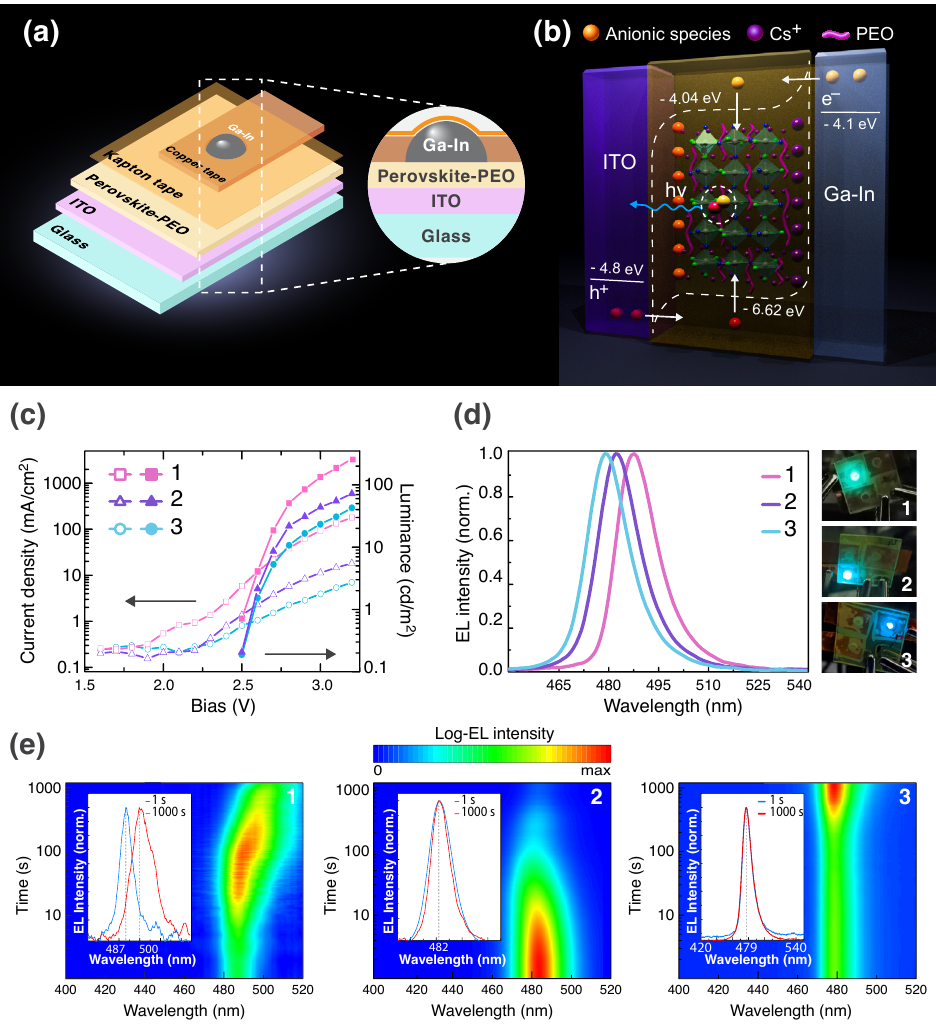
Figure 3. ( a ) The architecture of a PeLEC based on perovskite-polymer composite electroluminescent layer. A liquid Ga-In cathode is confined by the emissive layer, copper on insulator electrode, and Kapton tape. ( b ) The working principle of the studied PeLECs operation. Charge carriers are injected in the emissive layer from the electrodes and recombine in CsPb(Cl,Br) 3 grains. A wide bandgap Cs 4 Pb(Cl,Br) 6 insulating phase is omitted for clarity. ( c ) Current density–voltage and luminance–voltage relations for the devices 1 – 3 . ( d ) Normalized EL spectra and corresponding to them colors of light generated from the PeLECs operating at 3 V forward bias. ( e ) Electroluminescence temporal dynamics in the devices operating at 2.7 V bias. Inset images show EL spectra measured at the 1st (blue line) and 1000th second (red